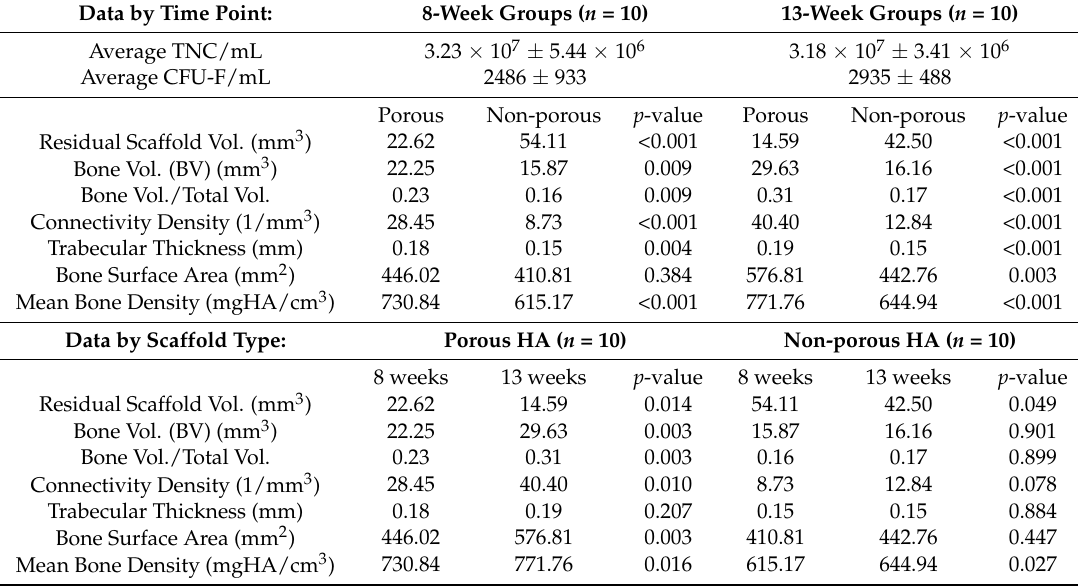
Table 1. Average total nucleated cell (TNC) and colony-forming unit-fibroblast (CFU-F) concentrations, and scaffold and bone characterization by MicroCT for porous and non-porous hydroxyapatite implants at 8- and 13-week harvest time points ( n = 10 per material per time